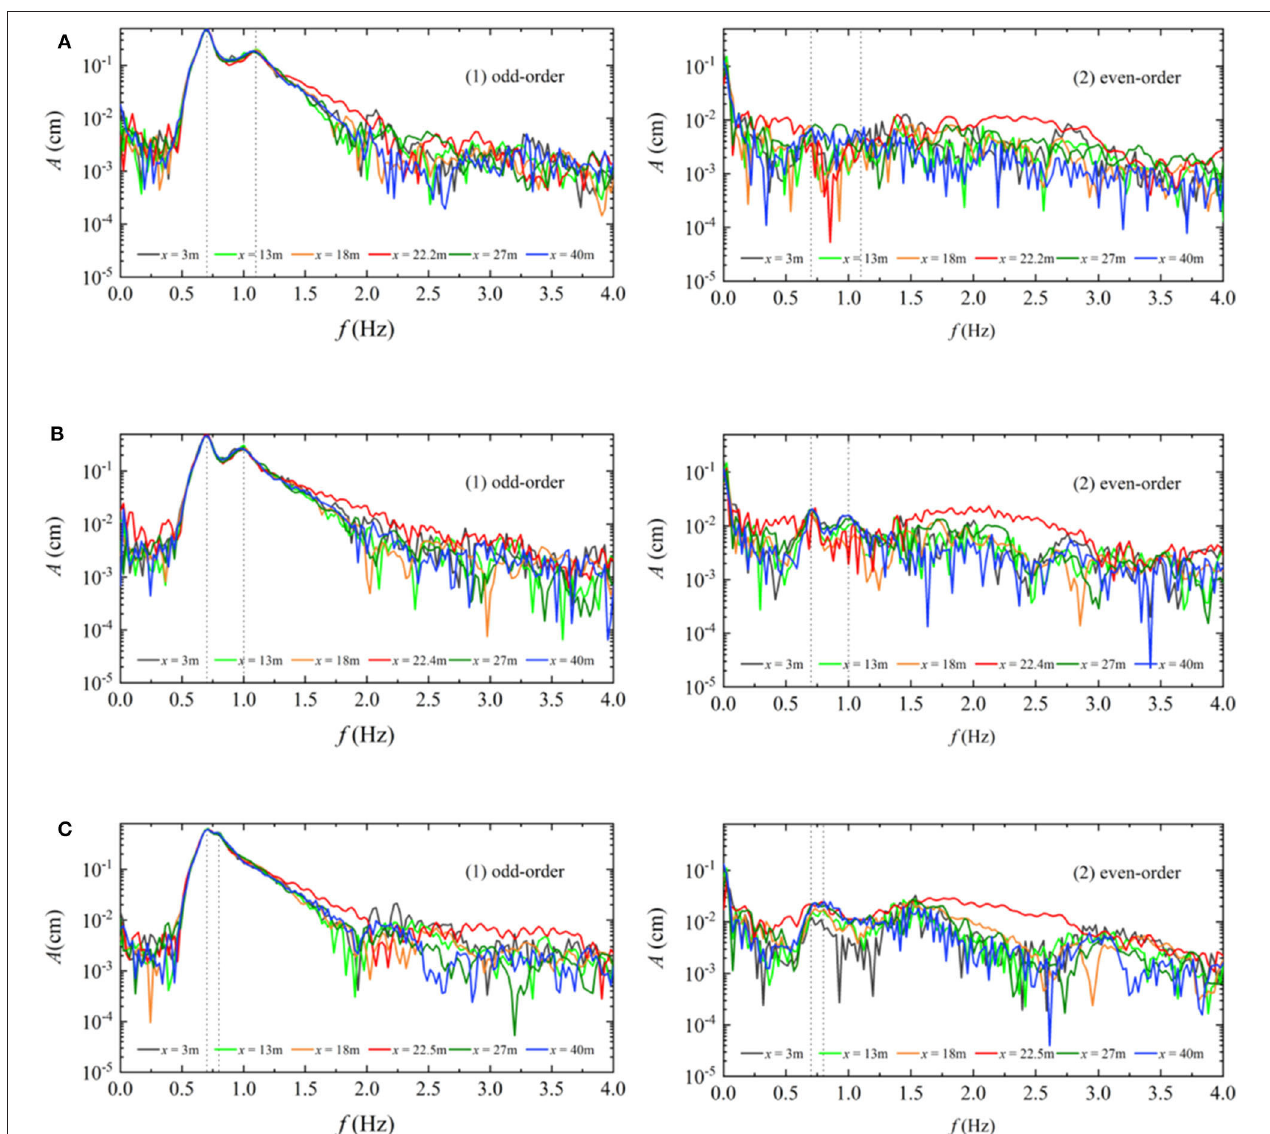
FIGURE 8 | The amplitude spectra of the odd- and even-order components. (A) Case 1_AB, (B) Case 2_AB, (C) Case 3_AB.